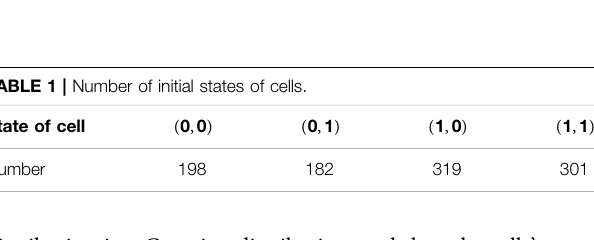
FIGURE 1 | State change in a system: (A) all nodes ’ state change, (B) one node of these nodes, and (C) the state change rule for one node, and there are eight states in these nodes.